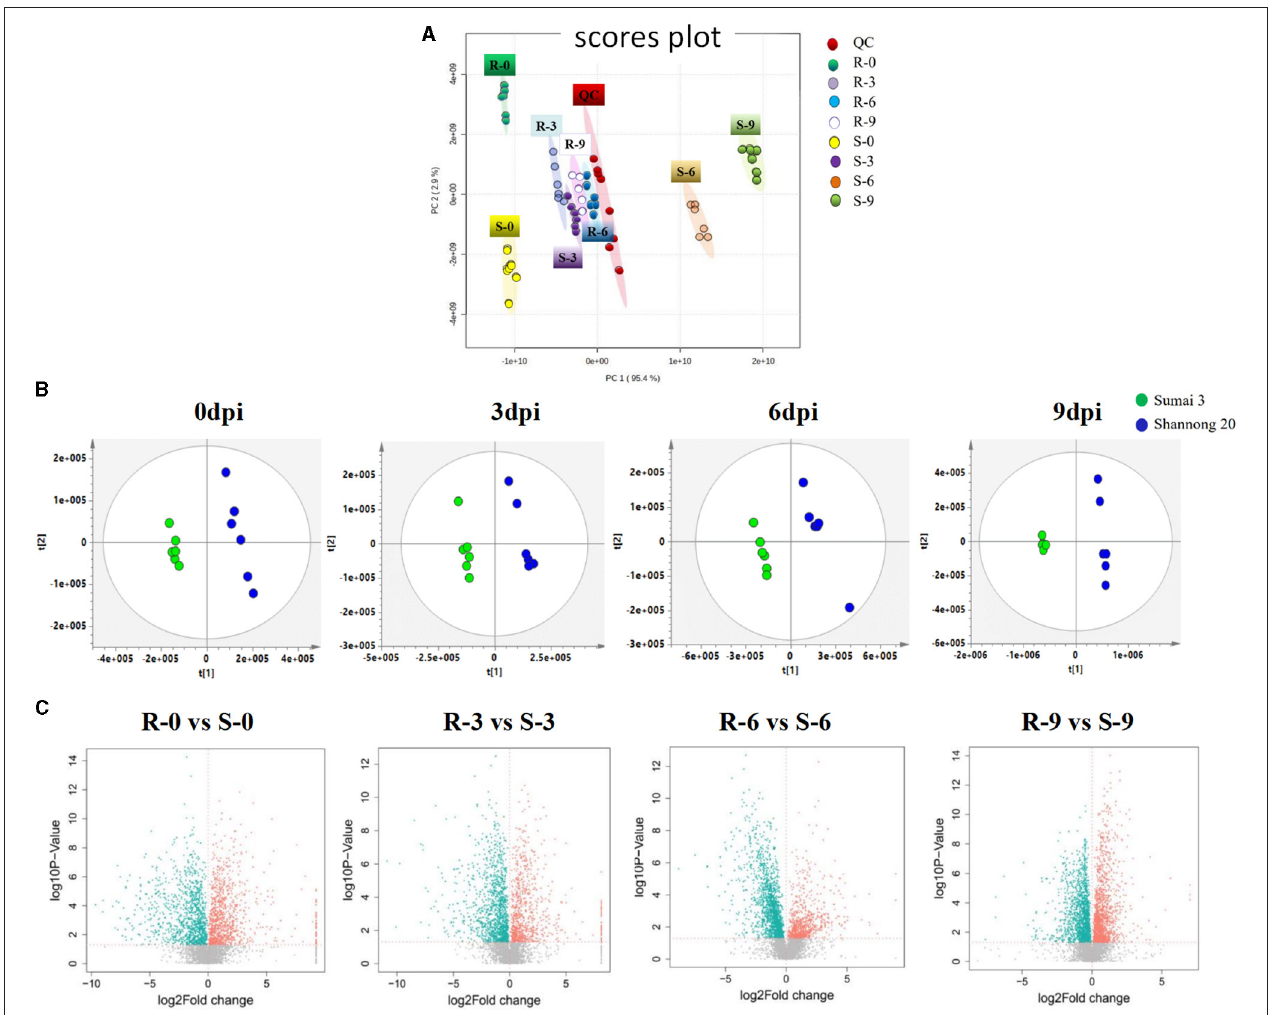
FIGURE 3 | F. graminearum inoculation induced a significant metabolic response in spikelets of wheat. (A) Principal component analysis (PCA) of metabolic profiles in all samples (six biological replicates). The partial least-squares discriminant analysis (PLS-DA) score plots (B) and a volcano plot (C) of the comparison between R-0 and S-0, R-3 and S-3, R-6 and S-6, R-9 and S-9, respectively. QC, Quality Control; R-0/3/6/9, resistant genotype (Sumai 3) at 0/3/6/9 dpi; S-0/3/6/9, susceptible genotype (Shannong 20) at 0/3/6/9 dpi.